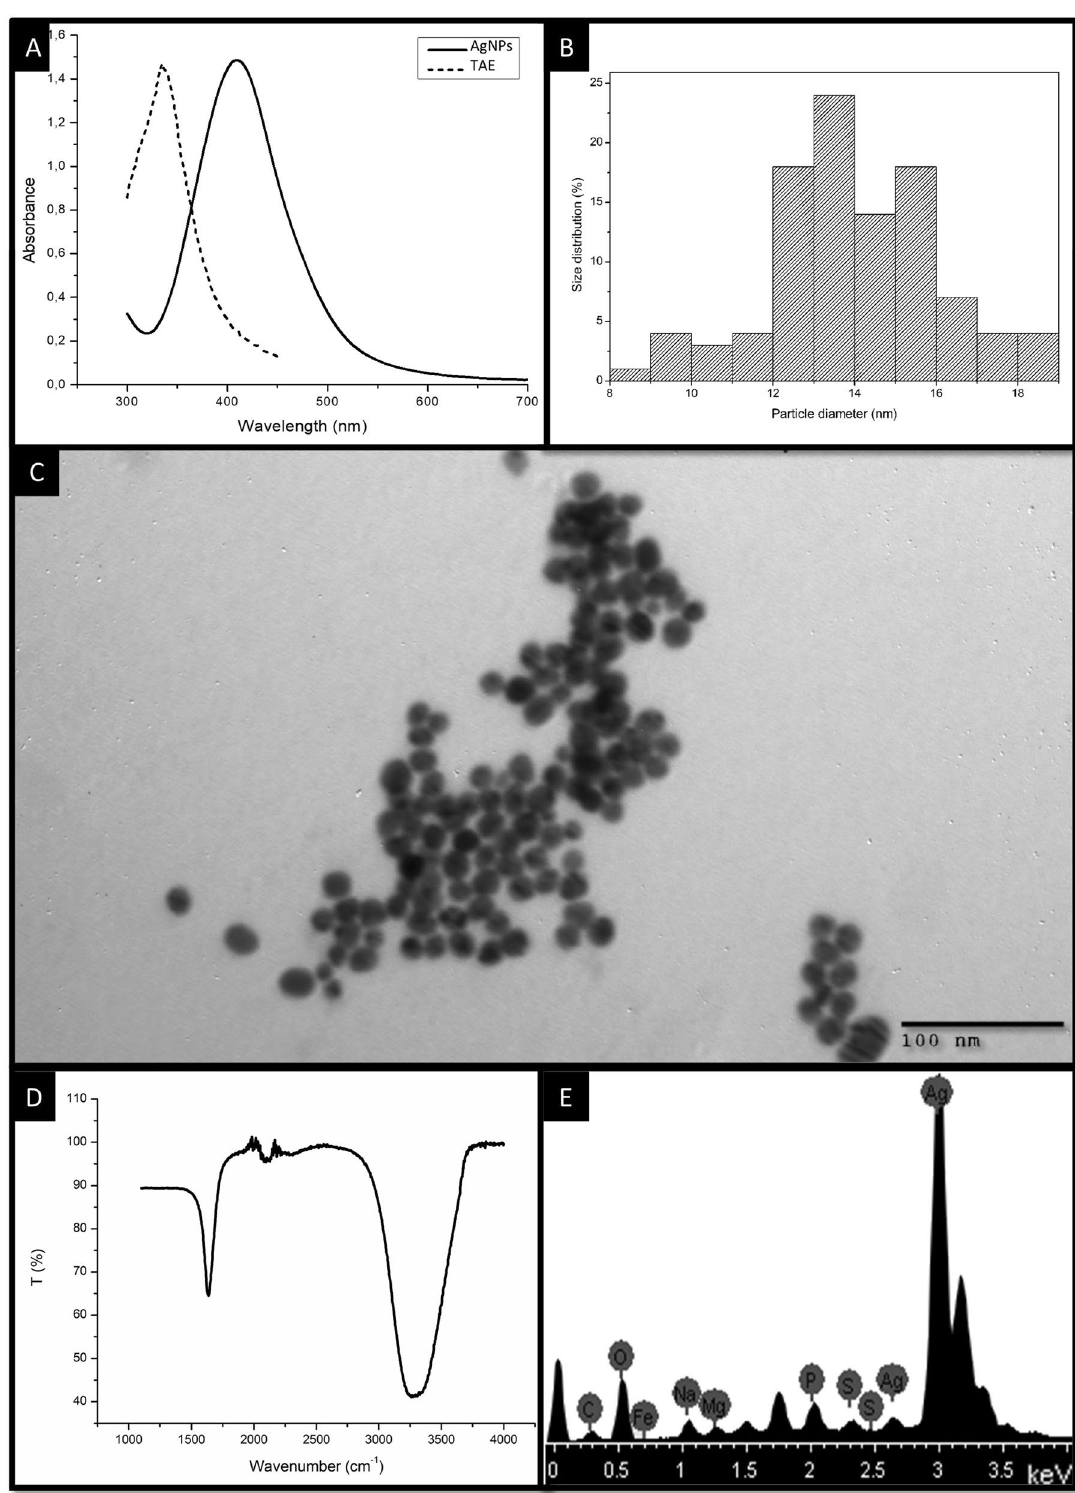
Figure 1. Characteristics of the synthesized AgNPs from TAE. ( A ) UV–visible spectrum. ( B ) Histogram of particle size distribution. ( C ) TEM image. ( D ) FTIR spectra. ( E ) EDX